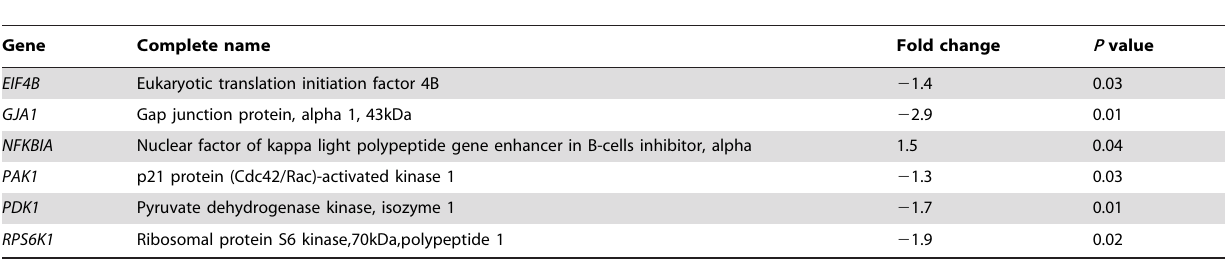
Table 3. In vivo effects of Reishi on the expression of PI3K/AKT/mTOR pathway genes.